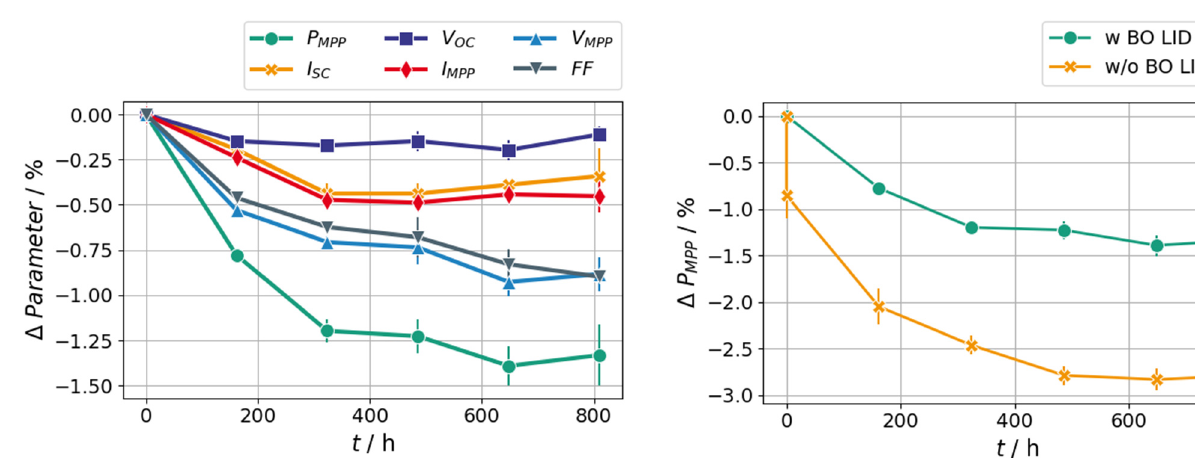
Fig. 7. Relative changes of P MPP at STC of modules during LETID testing at 75 ° C and MPP mode with (M04, M05) and without (M06, M07) prior BO LID stabilization. Average values over two modules; Error bars: min / max values of